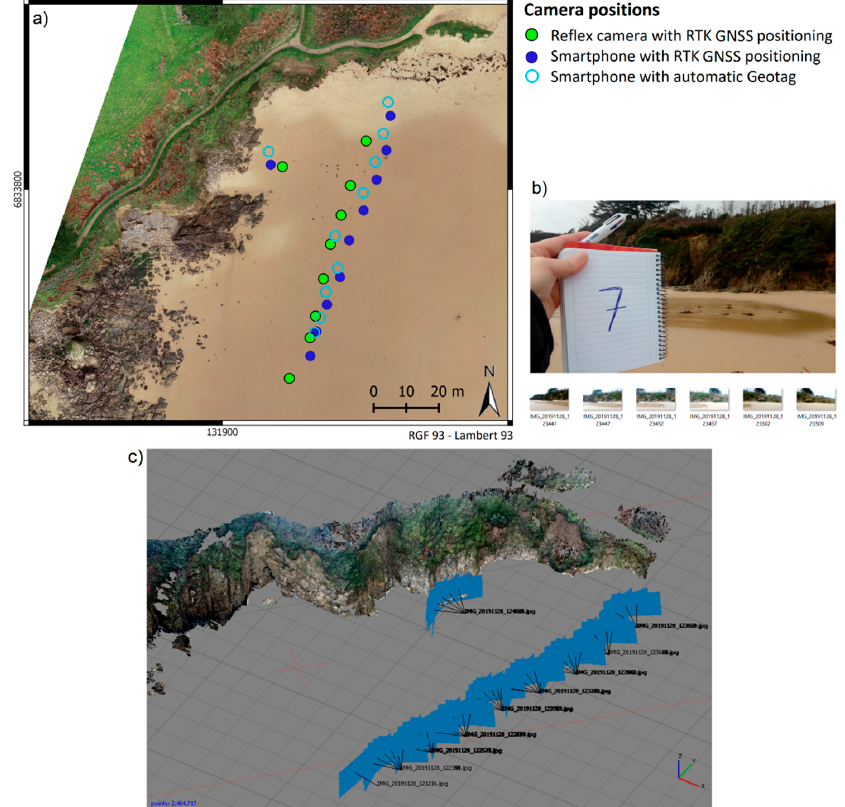
Figure 3. ( a ) Measured camera stations for the tests using Reflex Nikon D800 camera and Huawei Smartphone, respectively. For the Huawei smartphone, positions were recorded using both the internal GNSS system (automatic geotag) and the RTK GNSS-assisted method. ( b ) Example of a photograph taken at a new position, at the beginning of the series of photographs. ( c ) Example of dense point cloud reconstructed in Agisoft PhotoScan Pro ® for the Huawei Smartphone dataset. For measuring the entire cliff face, the setup was moved to different camera stations. For each station, approximately five to ten photographs are collected according to a “fan-shaped capture” (i.e., spinning the camera around the vertical axis [9]) and the station position is measured by RTK GNSS